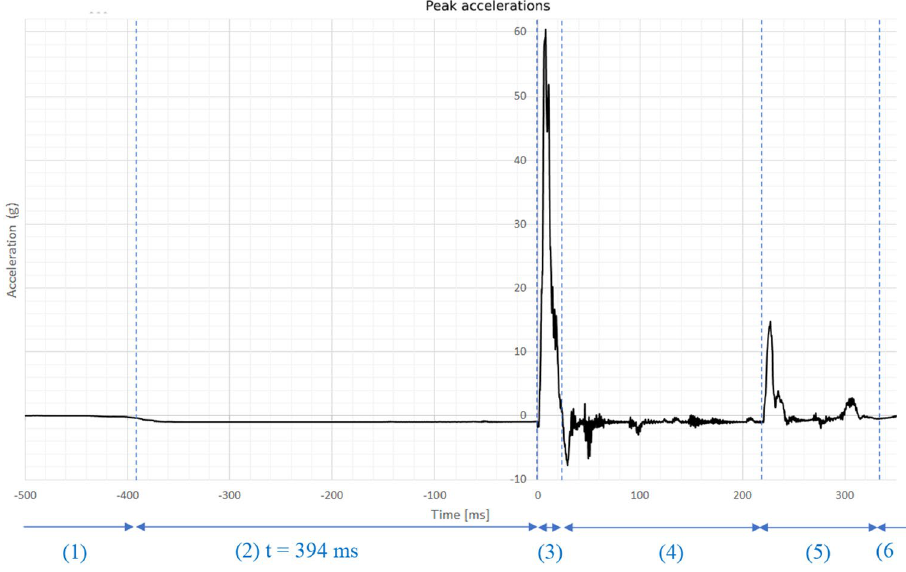
Fig. 12 Accelerations meas- ured in one single